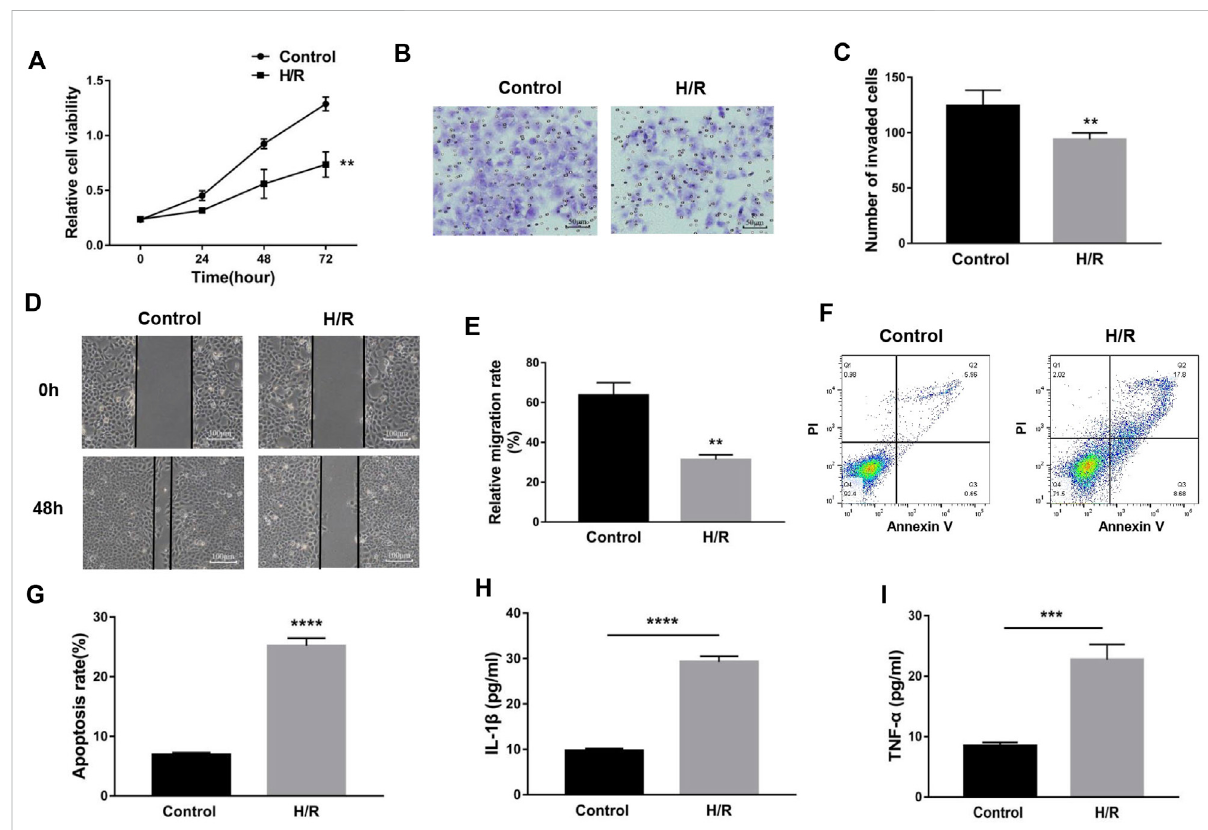
FIGURE 3 H/R-induced trophoblast dysfunction and in fl ammation were used to mimic preeclampsia. (A) Cell proliferation was determined by CCK-8 assay. (B,C) Cell invasion ability was determined by transwell assay. (D,E) Cell migration ability was determined by scratch assay. (F,G) The apoptosis rate was measured by fl owcytometry. ELISA was used to detect IL-1 β (H) and TNF- α (I) in the cell supernatant. n = 3/group. ** p < 0.01; *** p < 0.001; **** p <